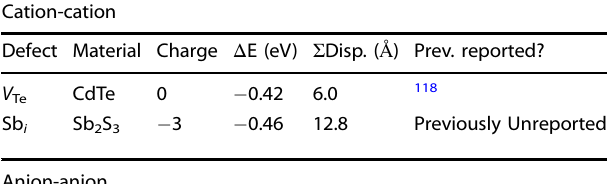
Table 1. Dimerisation. Energy difference and summed atomic displacements ( Σ Disp.) between the ground state a identi fi ed by our method and the metastable con fi guration b found when relaxing the ideal, undistorted defect structure (i.e., Δ E = E ground − E metastable ). The column ‘ Prev. reported? ’ indicates whether the identi fi ed con fi guration is only found with our method ( ‘ Previously Unreported ’ ) or had been reported previously by the referenced study.